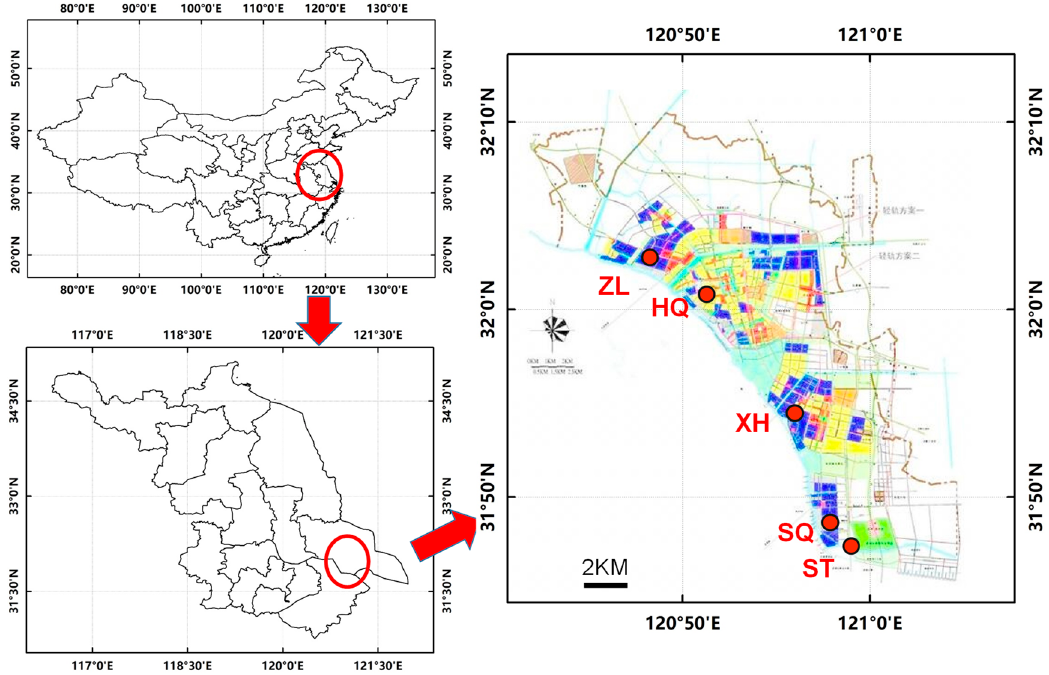
Figure 1. Sampling sites location in Nantong. The background blue color indicates industrial areas and yellow color indicates commercial and residential areas. ZL = Zilang. HQ = Hongqiao. XH = Xinghu. SQ = Sanqu. ST = Sutong.